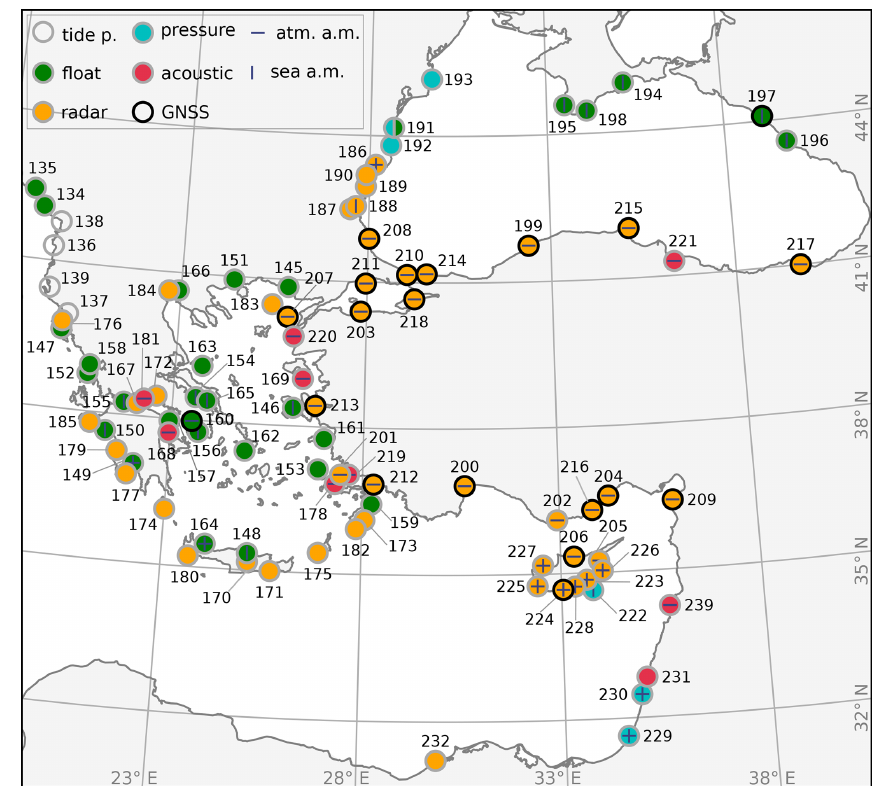
Figure 6. Same as in Fig. 4 but for the eastern Mediterranean Sea and for the Black Sea. Station names are listed in the Appendix tables: Tables A13–A14, A16–A25, and A27. Stations 137, 152, 156, 165, 168, 170, 172, 178, 205, and 222 are slightly shifted to ensure better